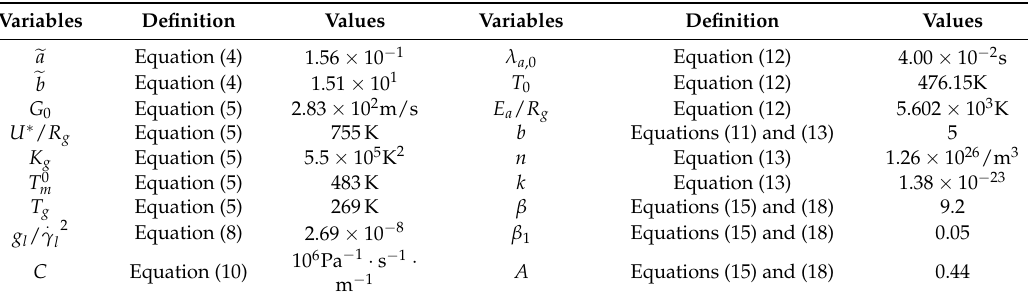
Table 1. Material data and input parameters.